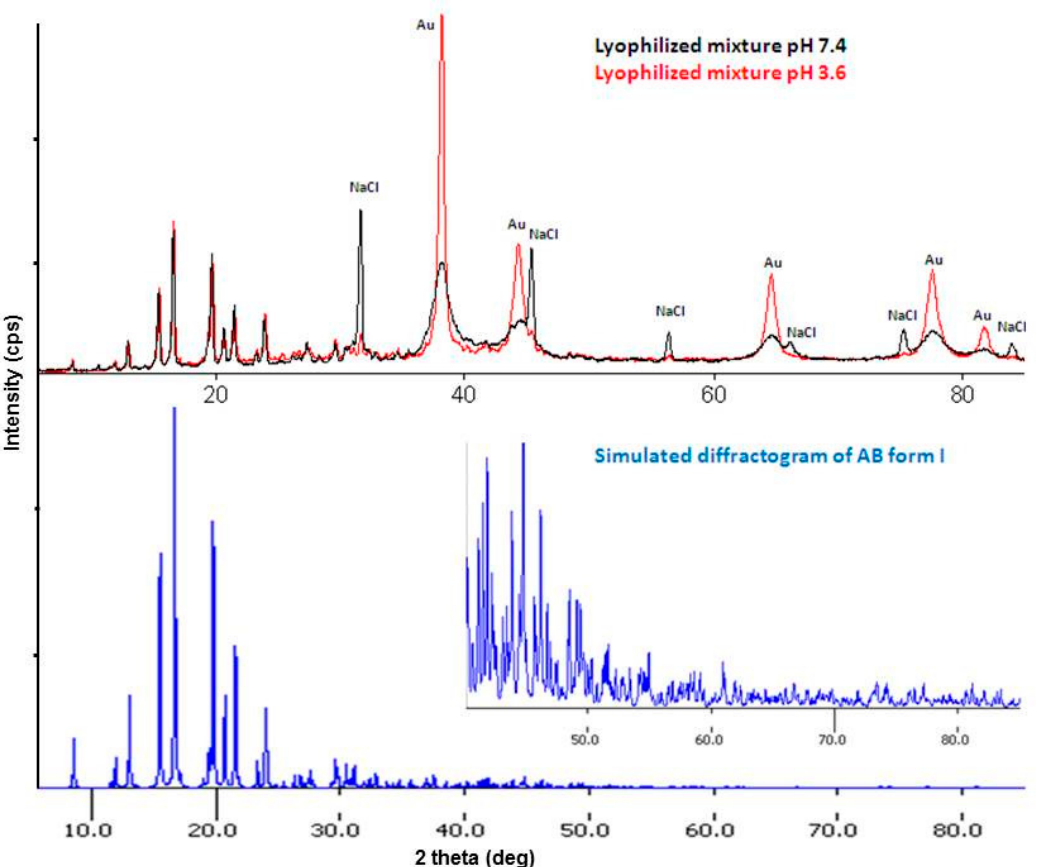
Figure 6. Identification of the crystalline phases in the lyophilized mixtures. Nanomaterials 2018 , 8 , x FOR PEER REVIEW